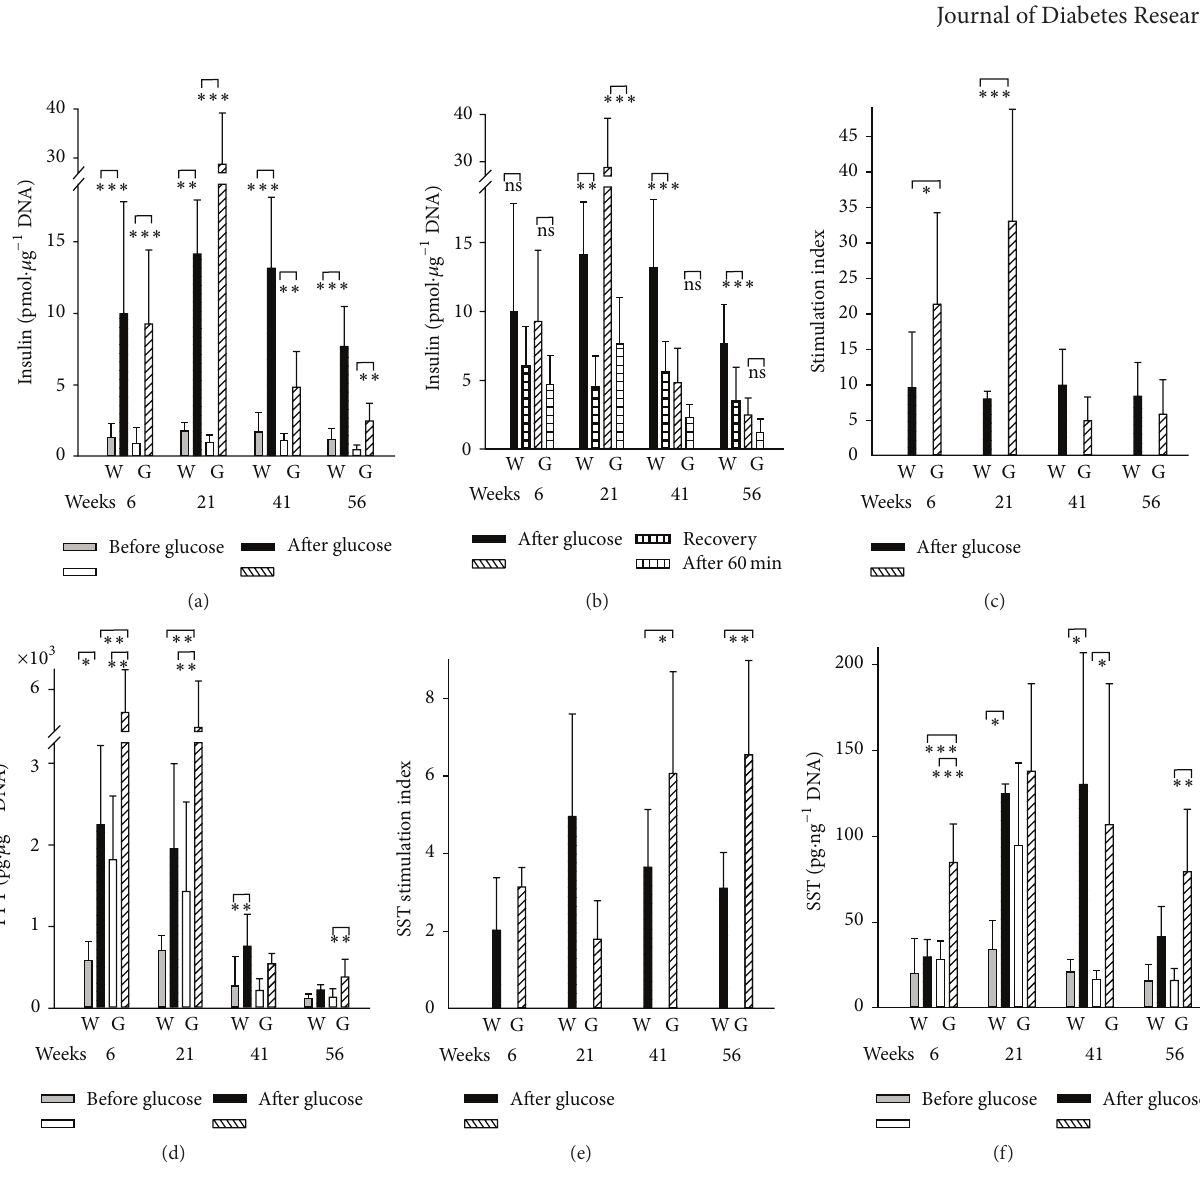
Figure 10: Glucose-stimulated insulin (a–c), PPY (d), and SST secretion (e, f) from isolated PI of Wistar and Goto-Kakizaki rats during aging. GSIS or glucose-stimulated secretion of PPY or SST was assayed for isolated PI of Wistar “W” and Goto-Kakizaki rats “G” of age in weeks indicated by numbers. Panels (a), (d), and (f) show insulin , PPY , or SST , respectively, in pmol per 𝜇 g DNA, pg per 𝜇 g DNA, or pg per ng DNA, released before (gray or white bars) and after glucose addition (black or dashed bars), while panel (b) repeats displays of insulin released after glucose addition (black or dashed bars) and compares them with magnitudes of a “ recovery ” established 60 min after the return into the low-glucose basal medium (horizontally dashed bars), and panels (c) and (e) show the calculated insulin (c) or SST (e) glucose-stimulation index as ratio of insulin or SST, respectively, released after versus that before glucose addition. ANOVA yielded ∗∗∗ 𝑝 < 0.001 , ∗∗ 𝑝 < 0.05 , or ∗ 𝑝 < 0.1 ; from the following ensembles: 𝑛 = 10 –14 in (a–c) (5–9 for 56 weeks), 𝑛 = 5 –8 in (d), and 𝑛 = 5 in (e,